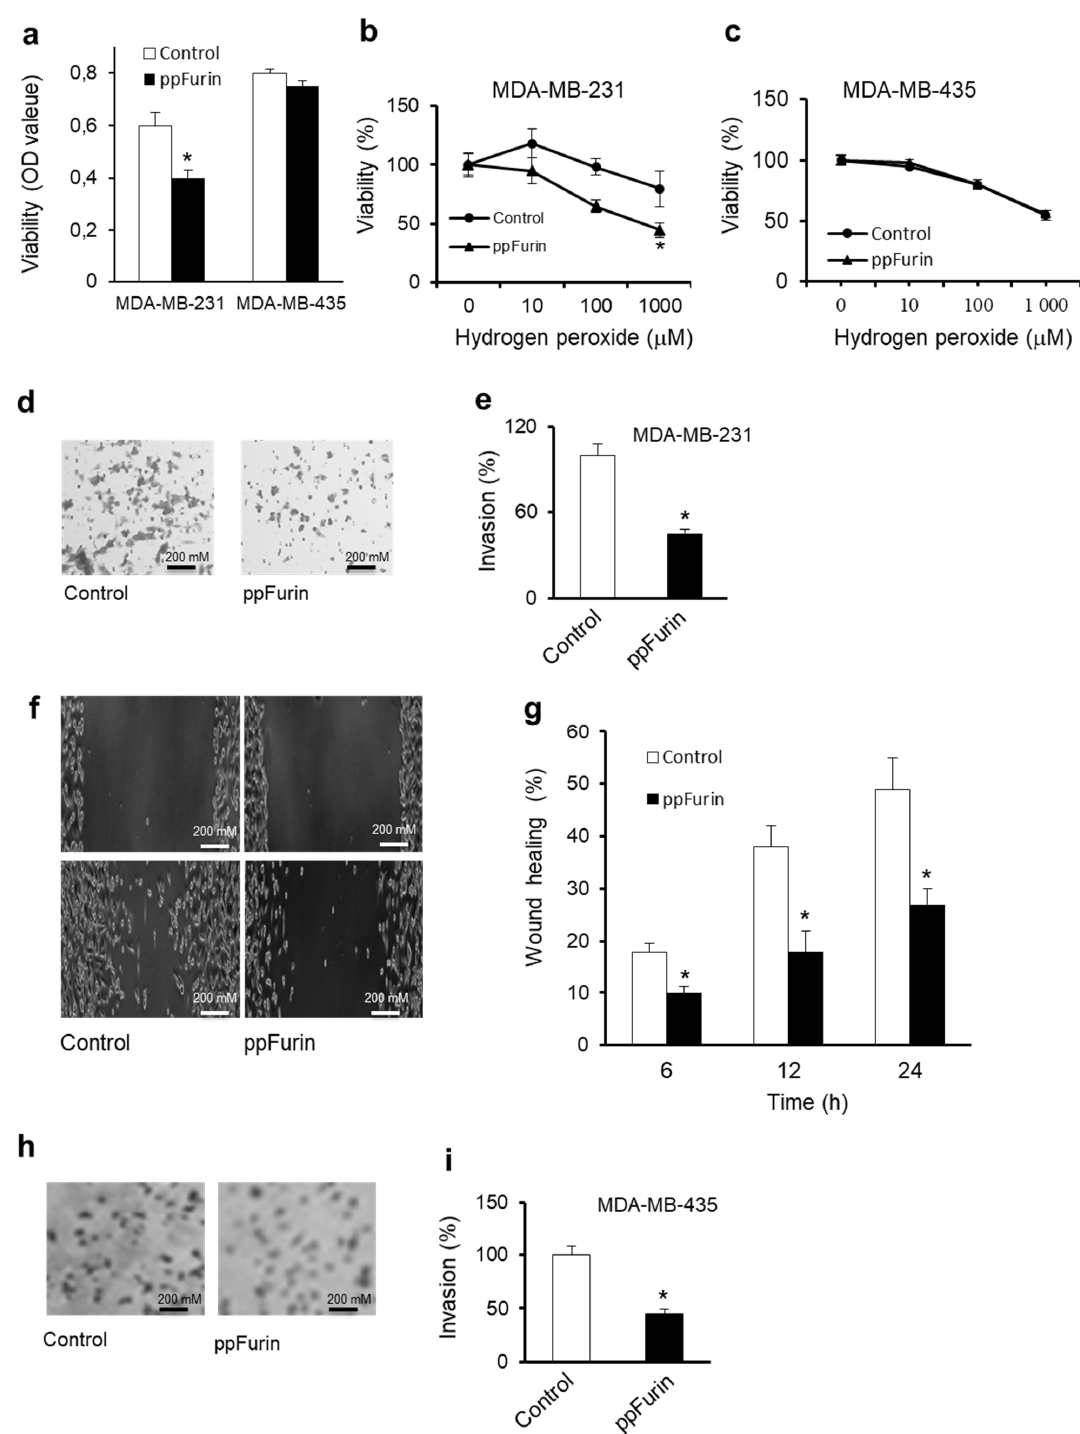
Figure 7. Effect of ppFurin on MDA-MB-231 cells malignant phenotype. ( a ) The optical density (OD) value measured from MTT assay represented basal cell viability of indicated control and ppFurin cells. ( b , c ) Effect of hydrogen peroxide on control and ppFurin-expressing MDA-MB-231 ( a ) and MDA-MB-435 ( b ) cells’ viability as assessed by MTT assay and calculated with respect to control, which is set as 100%. ( d , e ) Control and ppFurin-expressing MDA-MB-231 cells’ invasion. ( f , g ) Cell motility was analyzed by scratch wound assay. ( f ) Control and ppFurin-expressing MDA-MB-231 cells were subjected to scratch wounds and imaged after 24 h (n = 6/well). ( g ) Quantification of wound closure after 6, 12, and 24 h. ( h , i ) Control and ppFurin-expressing MDA-MB-435 cells’ invasion. All data are representative of 3 experiments and shown as mean ± S.E.M (n = 3 per group). * p < 0.05. Student’s t -test was applied for statistical analysis. p values of <0.05 were considered